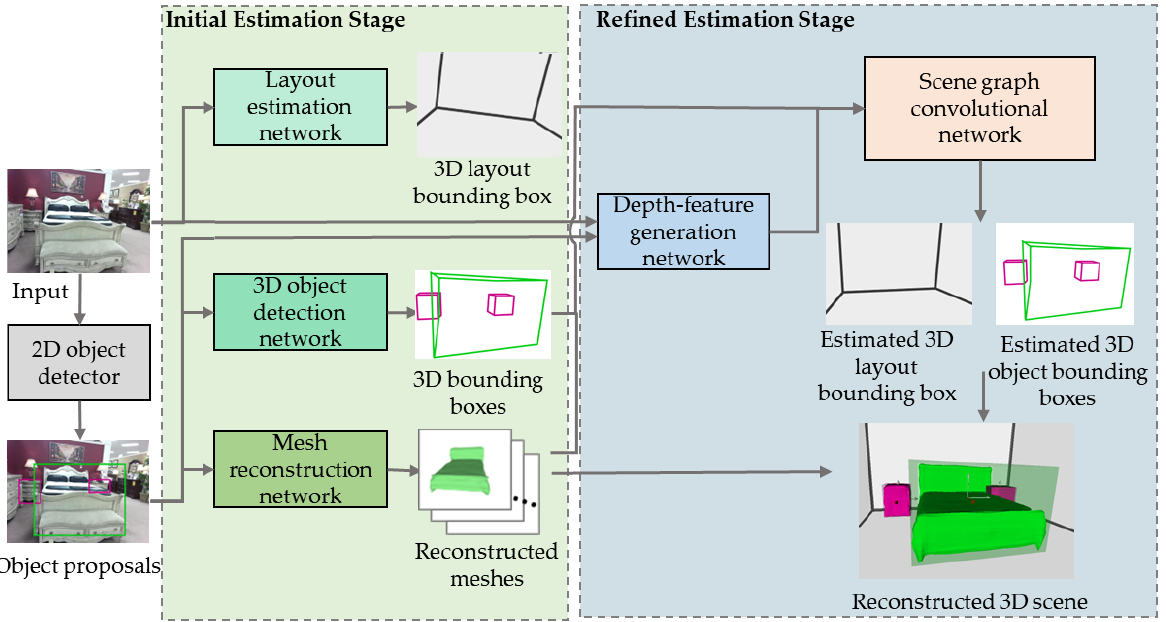
Figure 2. Overview of the proposed method. The input image is first preprocessed using a 2D object detector which outputs the 2D bounding boxes and categories of objects depicted in the input image. Then the 3D bounding boxes of layout and objects and 3D meshes are estimated in the initial estimation stage and further refined in the refined estimation